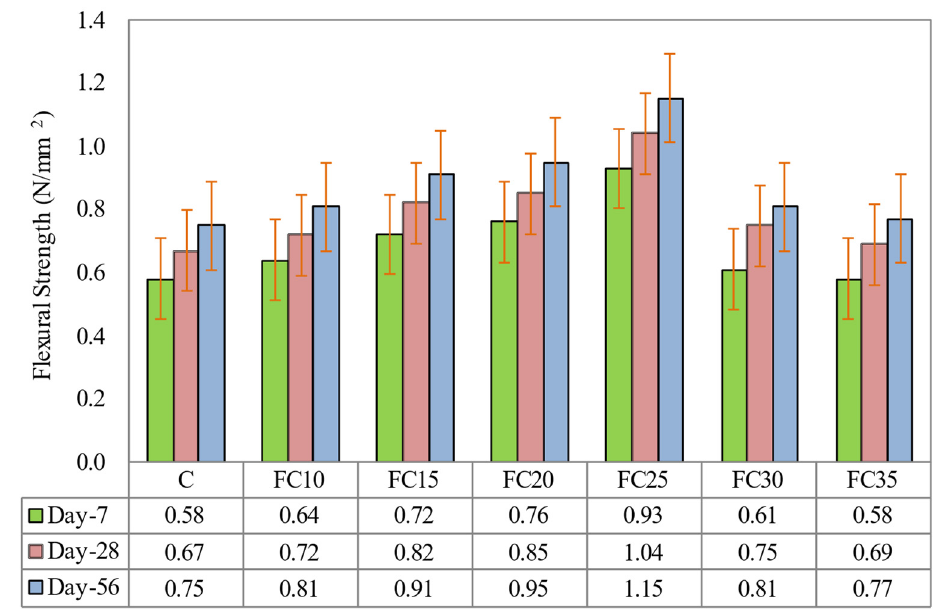
Figure 10. Influence of different weight fractions on flexural strength of LFC.